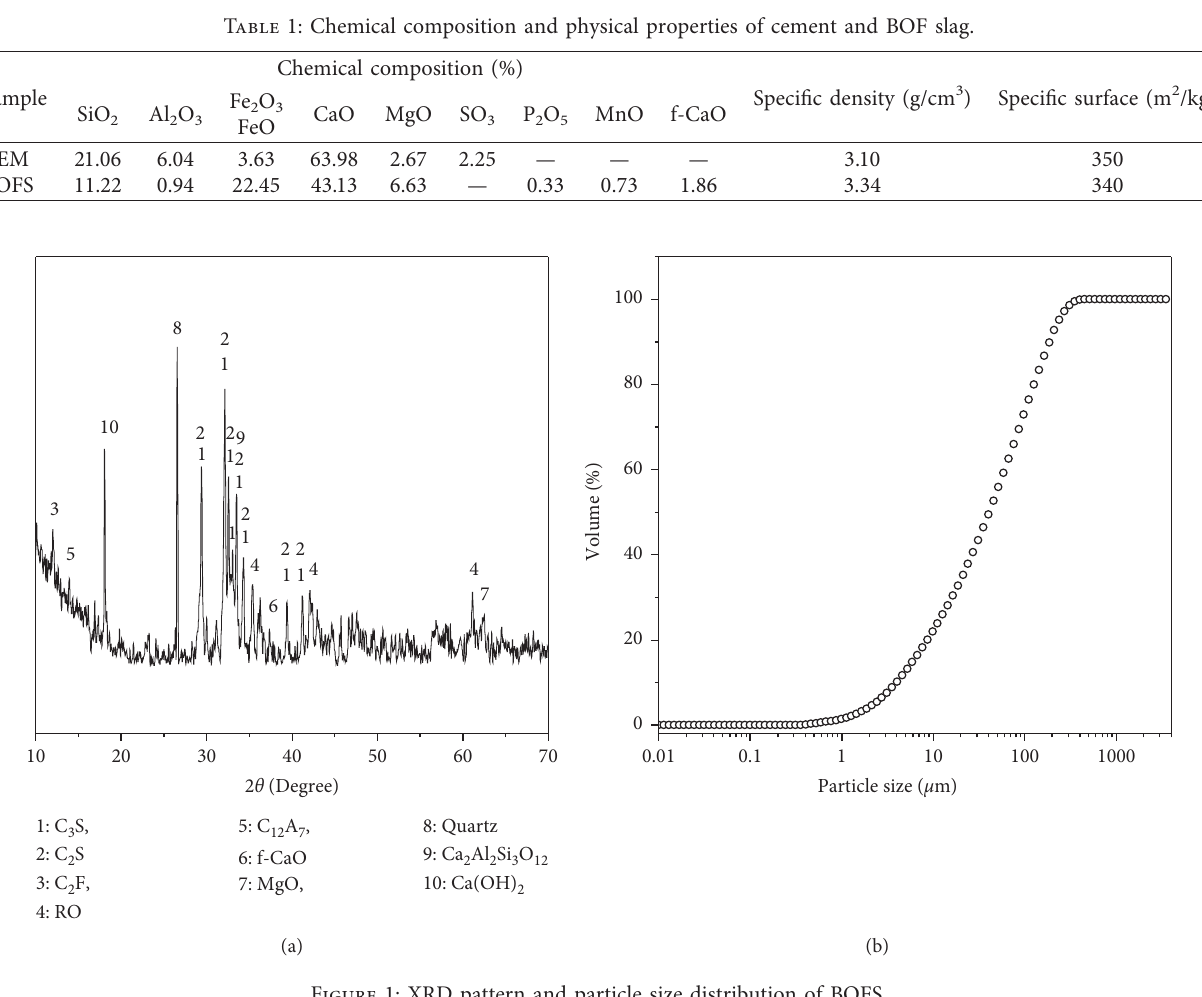
Figure 1: XRD pattern and particle size distribution of BOFS. Table 2: Mixture proportion of BOFS-blended mixtures.